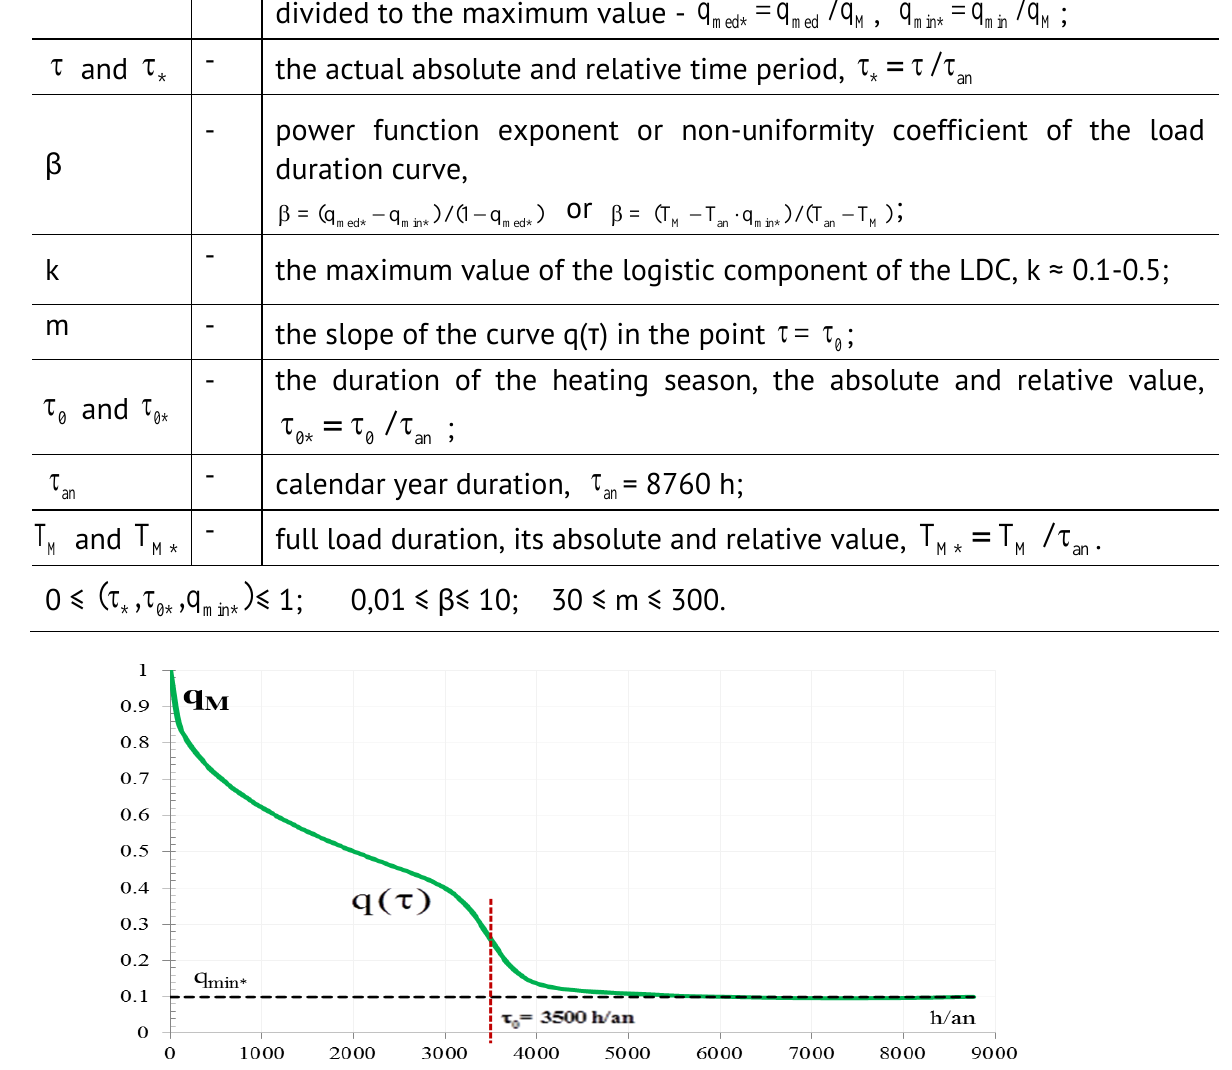
Figure 1. Load duration curve and the